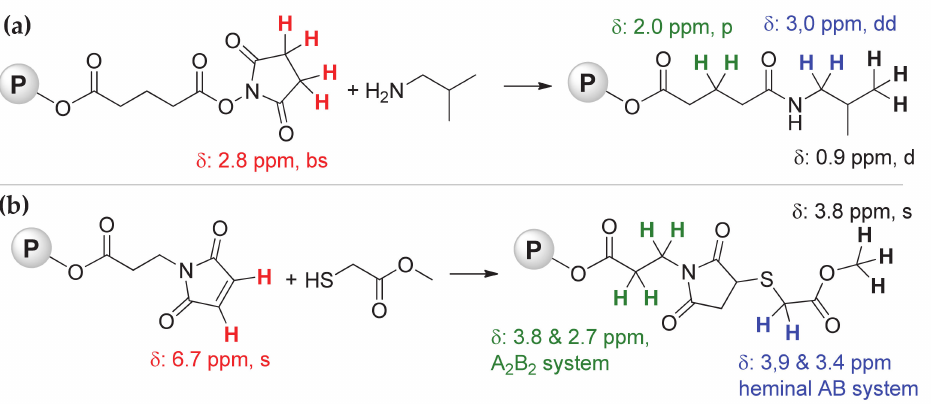
Scheme 3. Reactions of NHS- and MI-functionalized polymers with model amine and thiol, 1 H NMR criteria of the completion of the processes for NHS- and MI-terminated polymers, ( a ) and ( b ),